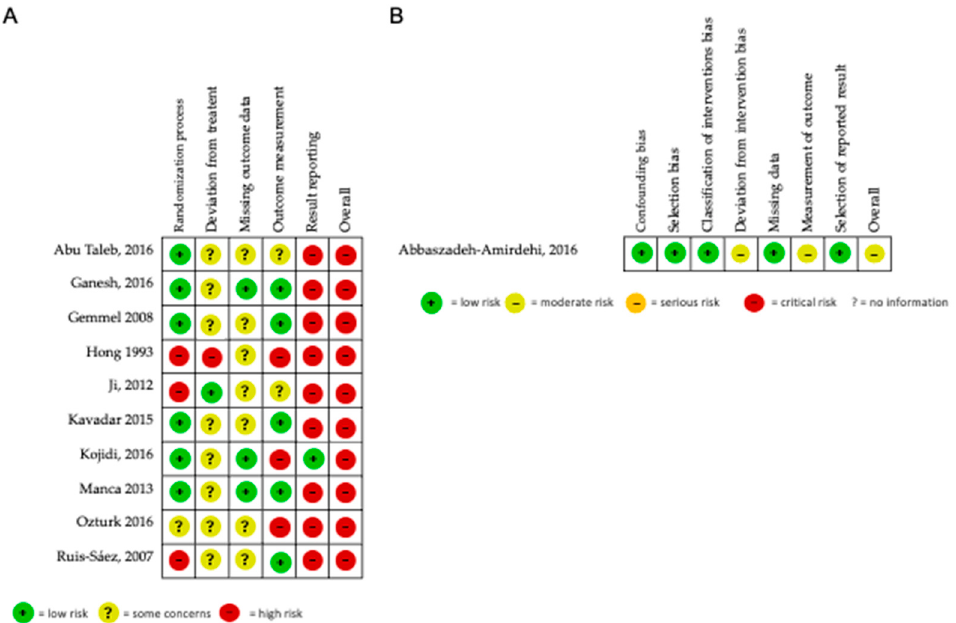
Figure 2. Risk of bias of the included studies. ( A ) RoB2 [51]; ( B ) ROBIN-I